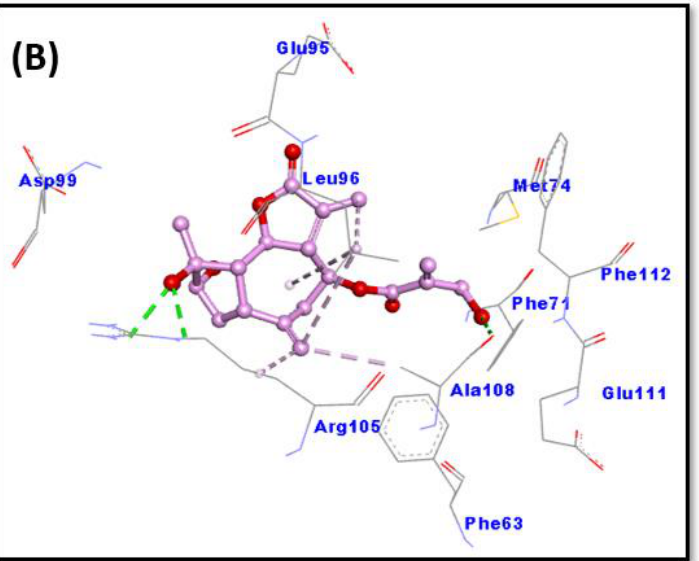
Figure 8. Molecular interaction between Bcl-2 and selected ligands. ( A ) Bcl-2 and DRO interaction, and ( B ) Bcl-2 and chlorojanerin interaction. Table 2. Molecular docking of chlorojanerin and DRO (control ligand) with Bcl-2.